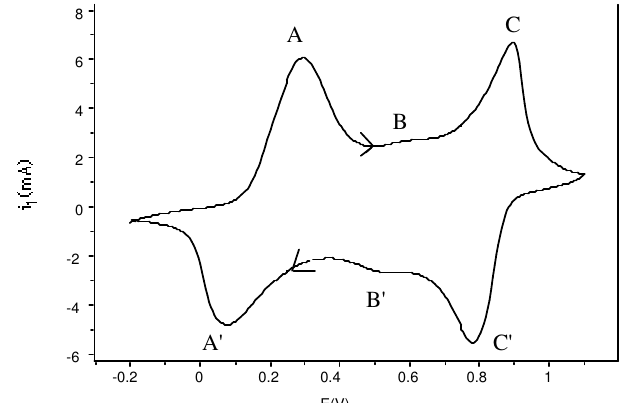
Figure 5. Typical cyclic voltammogram (CV) of Polyaniline synthesised electrochemically (Eapp.= 0.80 V versus Ag/AgCl) from a solution of 0.4M aniline and 1M HCl. CV was recorded after growth in 1M HCl as supporting electrolyte. Glassy carbon was used as the working electrode. Scan rate was 20 mV/s.